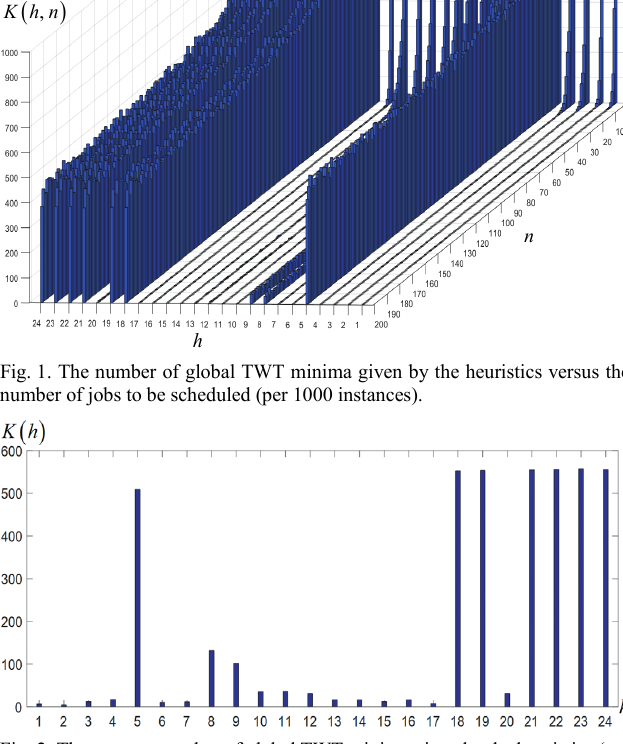
Fig. 2. The average number of global TWT minima given by the heuristics (per 1000 instances). Consider another case, when the job processing times and priority weights are not as scattered as given by (19) and (20).